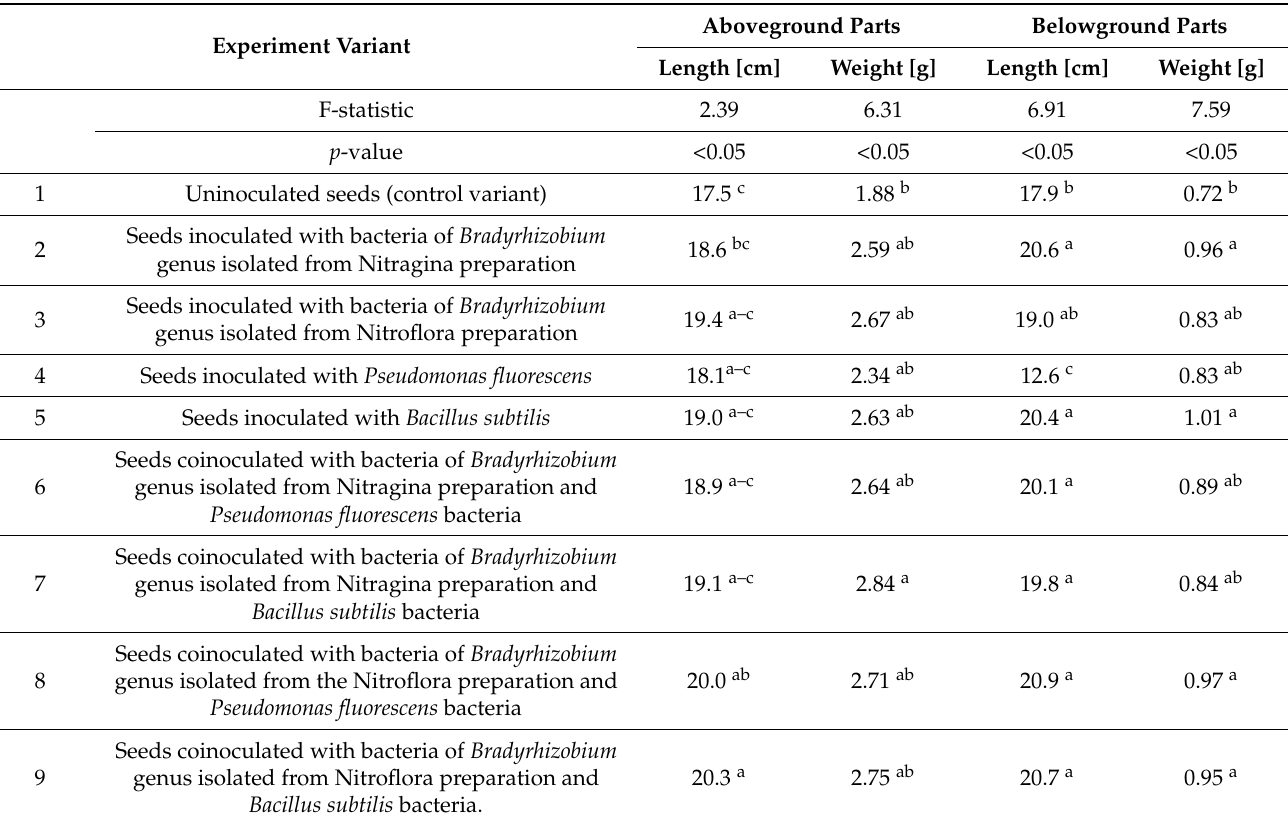
Table 2. The influence of the inoculation variant on the length and weight of the aboveground and belowground parts of white lupine. ANOVA and Tukey’s post hoc test for inoculation